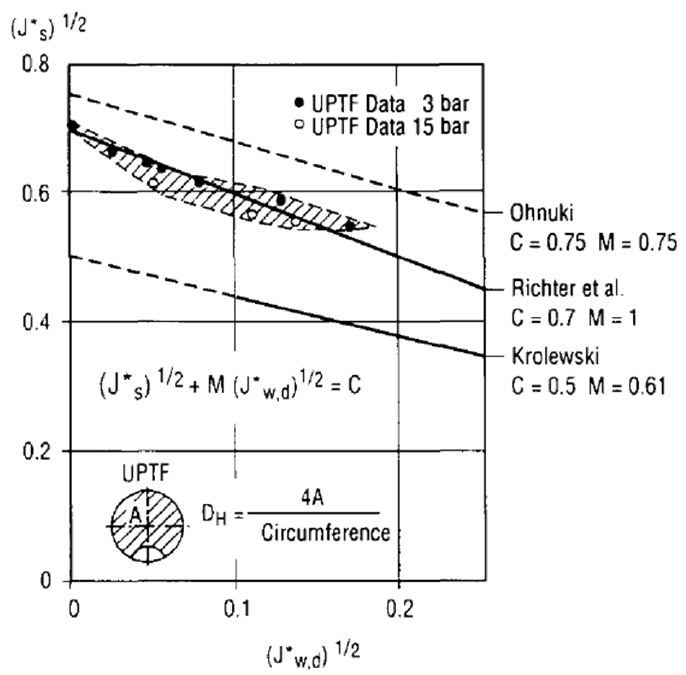
Figure 13. UPTF test data (Mayinger et al. [55]).